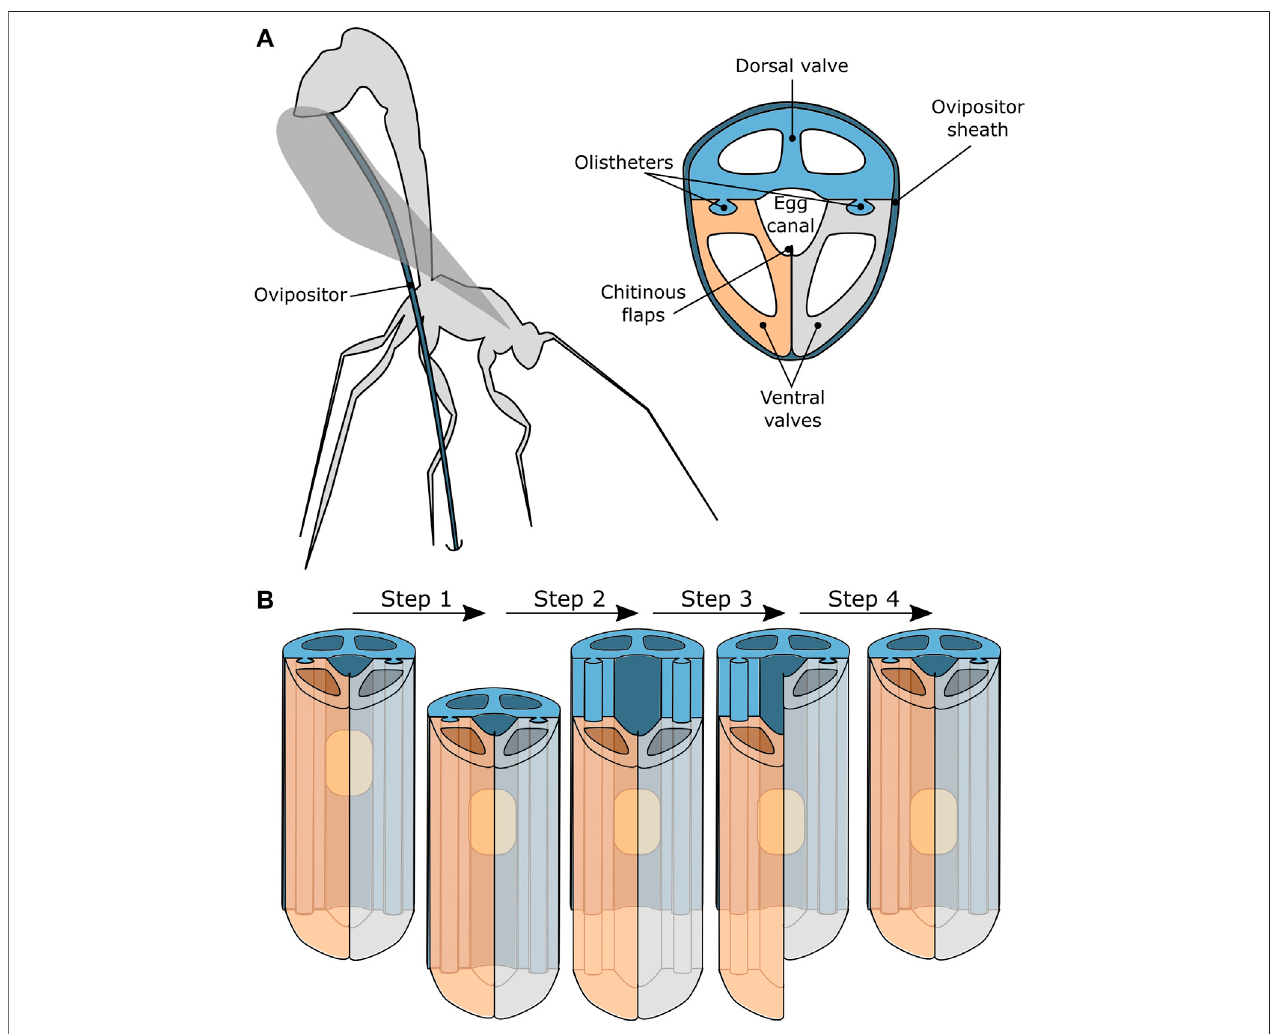
FIGURE 2 | Schematicrepresentationofa parasitic wasp thatusesa needle-like organ calledanovipositortotransport eggsintohostmaterial(Austinand Browning, 1981; Cerkvenik et al., 2017; van Meer et al., 2020). (A) The ovipositor generally consists of one dorsal valve and two ventral valves that are held together by tongue-and- groove connections, called olistheters, that allow the valves to slide with respect to each other. The chitinous fl aps prevent the egg from escaping the egg channel and the ovipositor is covered by the ovipositor sheath. (B) A possible motion sequence of the valves that results in transport of the eggs along the ovipositor.